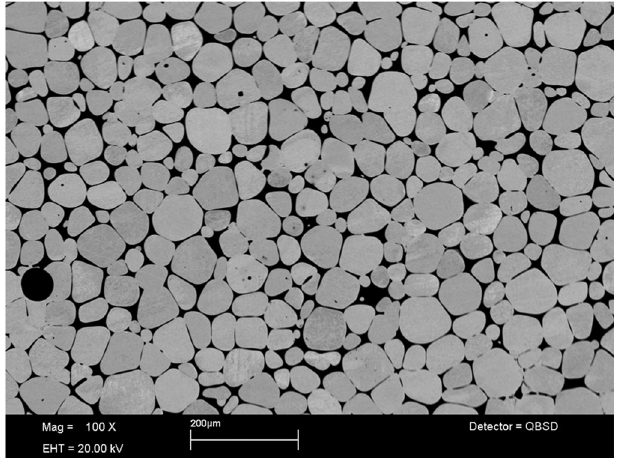
FIG. 8. Scanning electron microscope (SEM) image at low magnification ( 100 ×) showing the typical microstructure of INERMET ® 180. The tungsten grains are clear while the binder phase appears black.